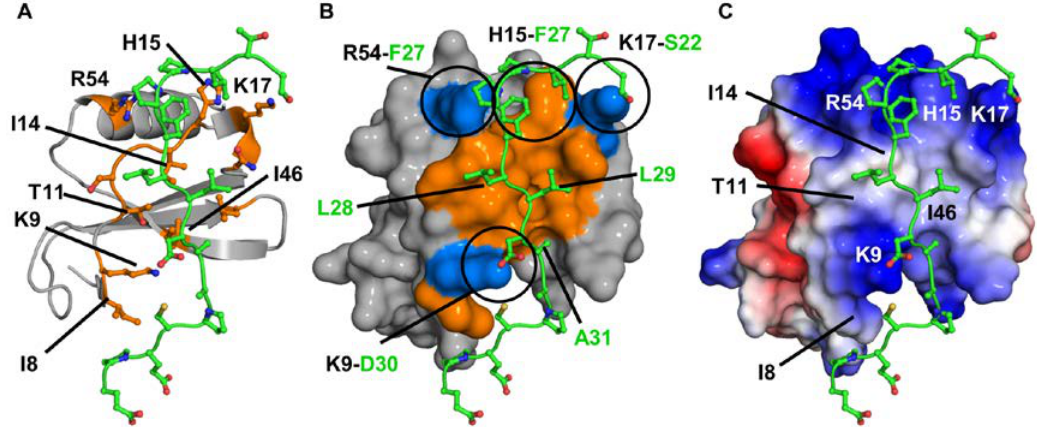
Figure 5. Model of the CXCL7-CXCR2 N-domain complex. ( A ) The ribbon diagram highlights the important binding residues on CXCL7 (orange). The receptor peptide is shown in green; ( B ) A surface filling model of the complex in the same orientation as shown in ( A ), highlighting residues involved in packing (orange) and ionic (blue) interactions. Several intermolecular interactions are circled and CXCL7 and receptor residues are labeled in black and green, respectively; ( C ) A schematic of the electrostatic surface in the same orientation as shown in ( A , B ) highlighting the hydrophobic pocket and the flanking basic residues. Important CXCL7 residues are labeled for reference.